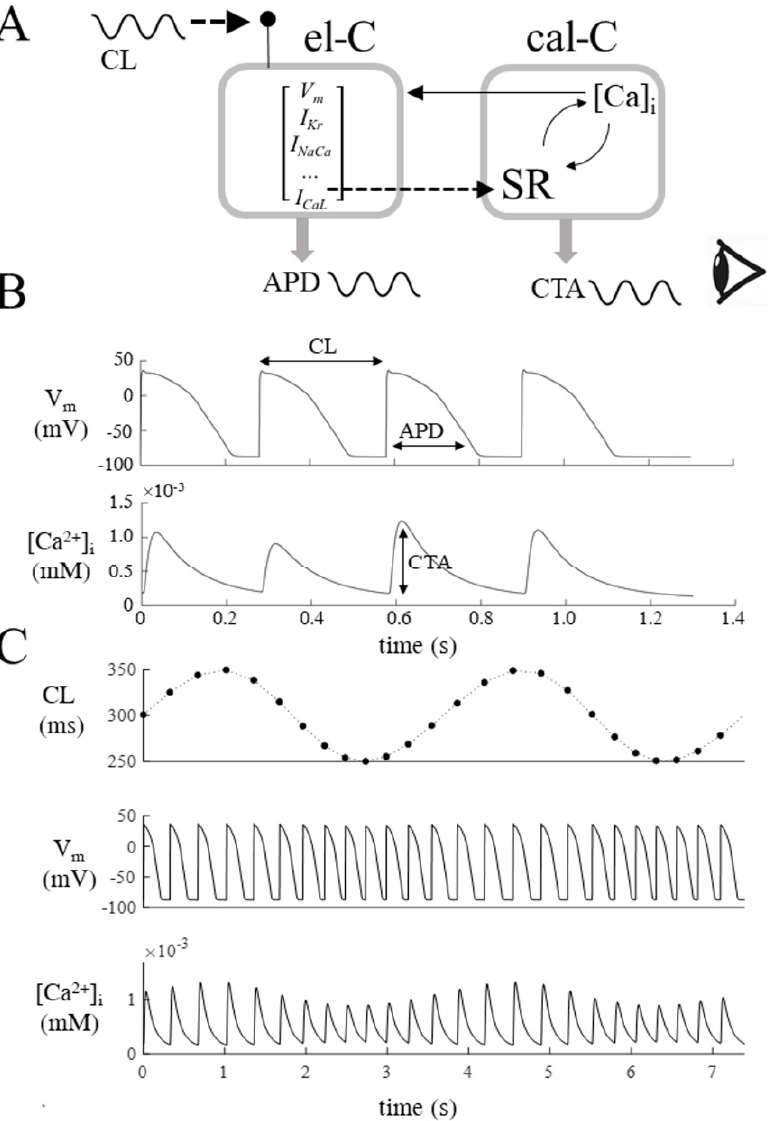
Figure 1. Oscillations of APD and CTA under oscillatory pacing. ( A ): Schematic representation of cellular ventricular EC coupling. The membrane excitability (el–C) and calcium handling (cal–C) counterparts are monitored experimentally through APD and CTA. el–C is paced at every CL via a brief current injection (I st ) and, at the same CL, the calcium current I CaL triggers cal–C to initiate the calcium cycle. ( B ): Sequences of APs and CTs are simulated while CL changes on a beat-to-beat basis, and corresponding APDs and CTAs are recorded. ( C ): When CL oscillates around a given value (top panel), APDs (middle pannel) and CTAs (bottom panel) also oscillate at the same fre-